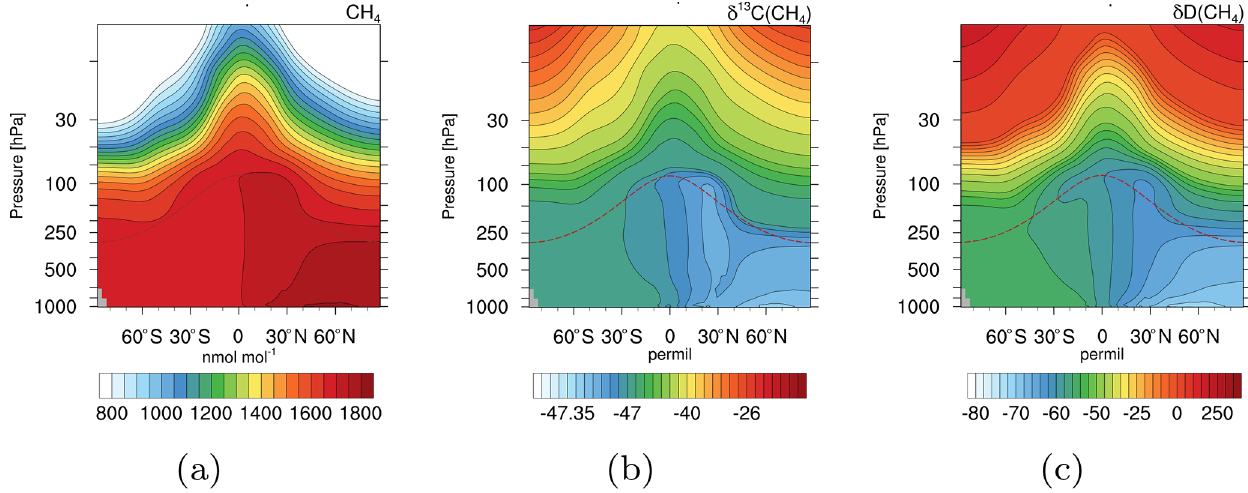
Figure 5. Zonal mean climatologies of 2000–2009 for CH 4 in nmolmol − 1 (a) , δ 13 C(CH 4 ) in ‰ (b) , and δ D(CH 4 ) in ‰ (c) of the simulation with EMAC and the CH4 submodel. The dashed brown lines indicate the height of the climatological tropopause.